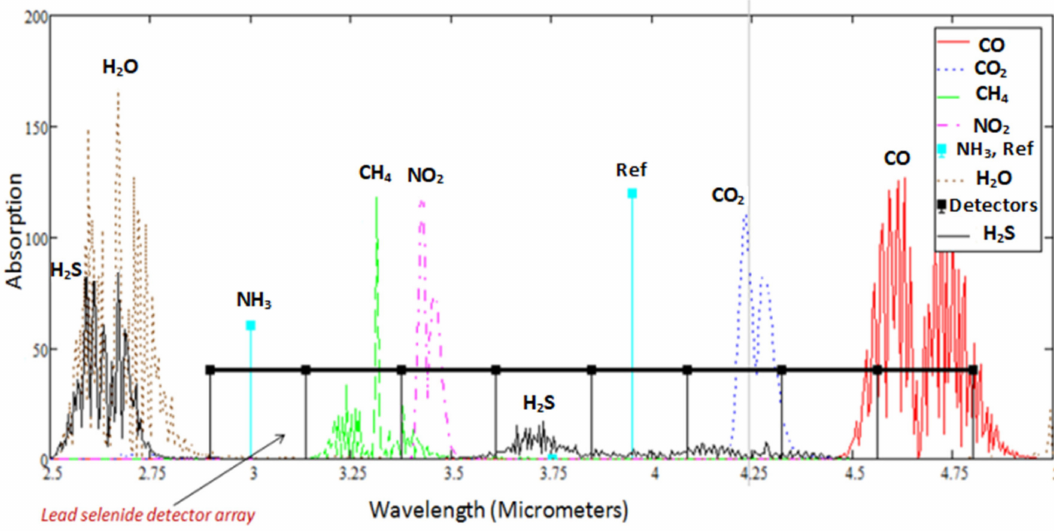
Figure 3. Lead selenide detector alignment with gas absorption